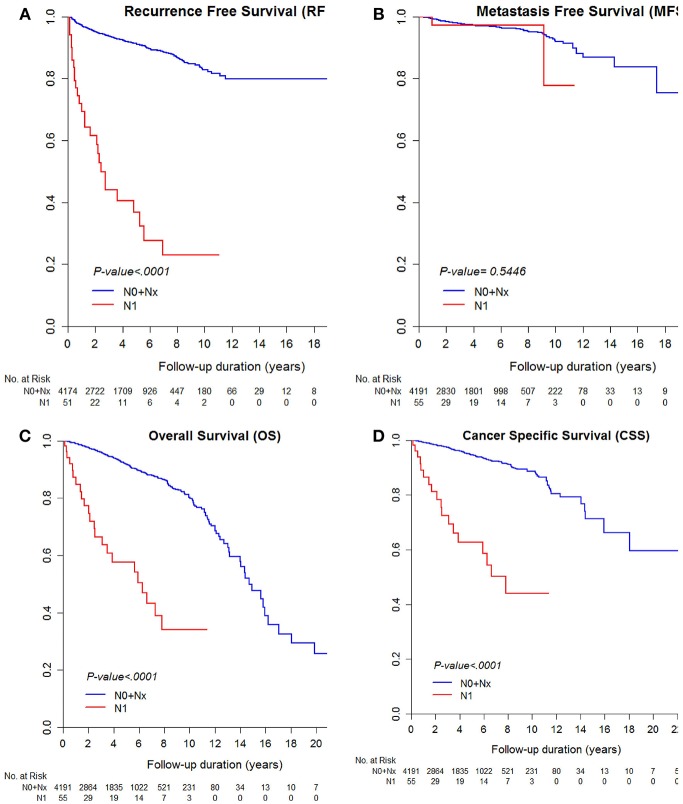
Kaplan-Meier curve for (A) recurrence-free survival, (B) metastasis-free survival, (C) overall survival, and (D) cancer-specific survival according to pathological N stages.